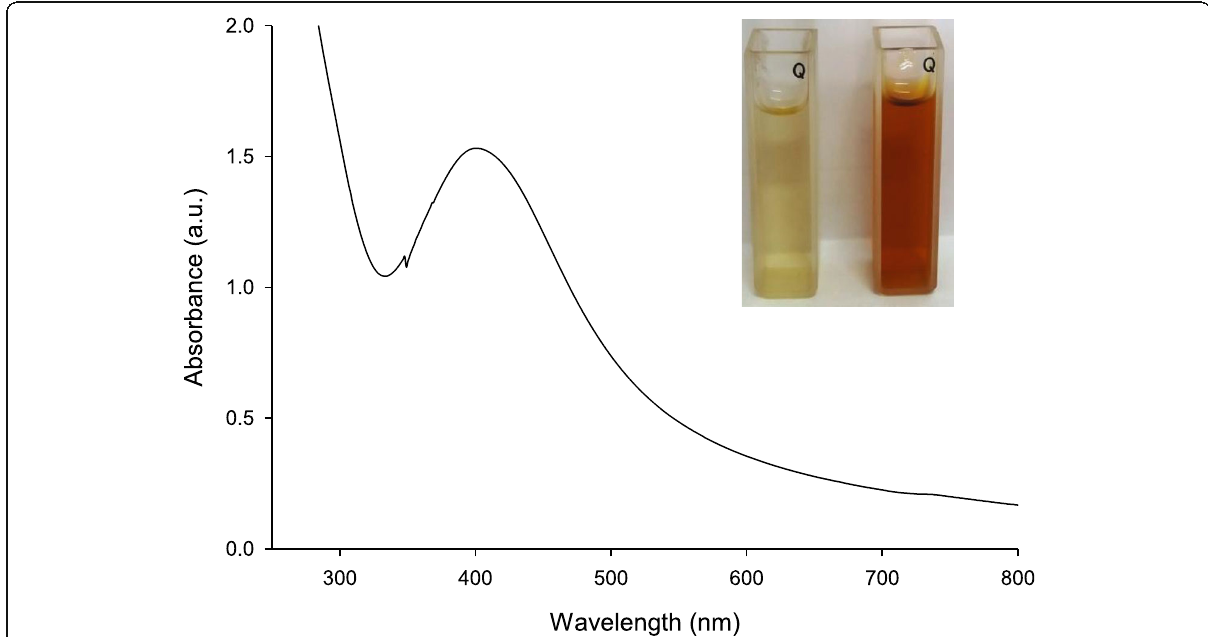
Fig. 1 UV – visible absorption spectrum of the biosynthesized AgNPs. The inset photo shows the change of reaction mixture color to